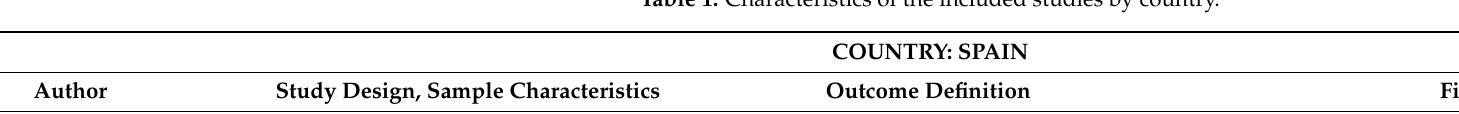
Table 1. Characteristics of the included studies by